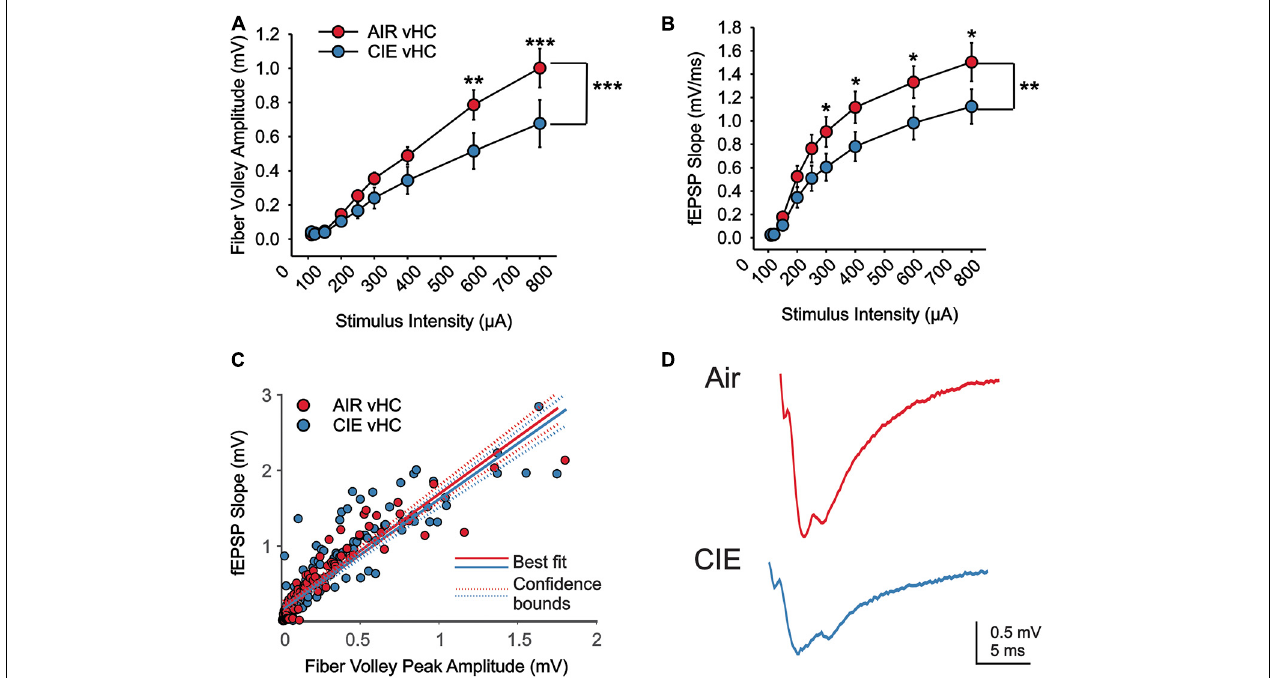
FIGURE 5 | There is a reduction in excitatory neurotransmission in the vHC of CIE-treated rats. There is a CIE-dependent reduction in the stimulus dependent (A) fV amplitude and (B) fEPSP slope. (C) The relative balance between vHC fV amplitude and fEPSP was not impacted by CIE-treatment. (D) Representative example traces of fEPSPs acquired from slices of an Air (upper trace) and CIE-treated (lower trace) rat. All data are expressed as the mean ± SEM, * p < 0.05, ** p < 0.01 and *** p < 0.001.